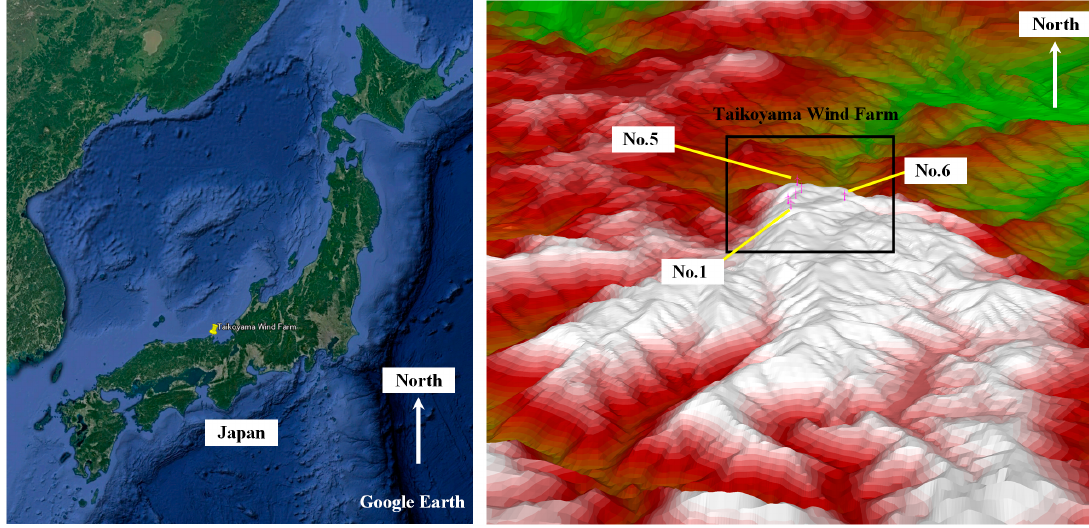
Figure 1. Location of Taikoyama Wind Farm in Kyoto Prefecture, Japan.